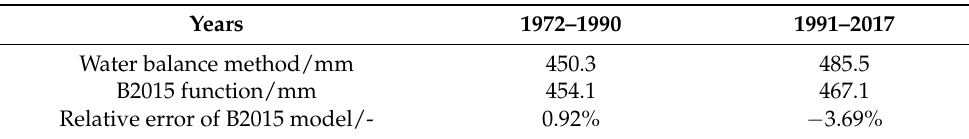
Table 2. AET of the different methods in the upper reach of Han